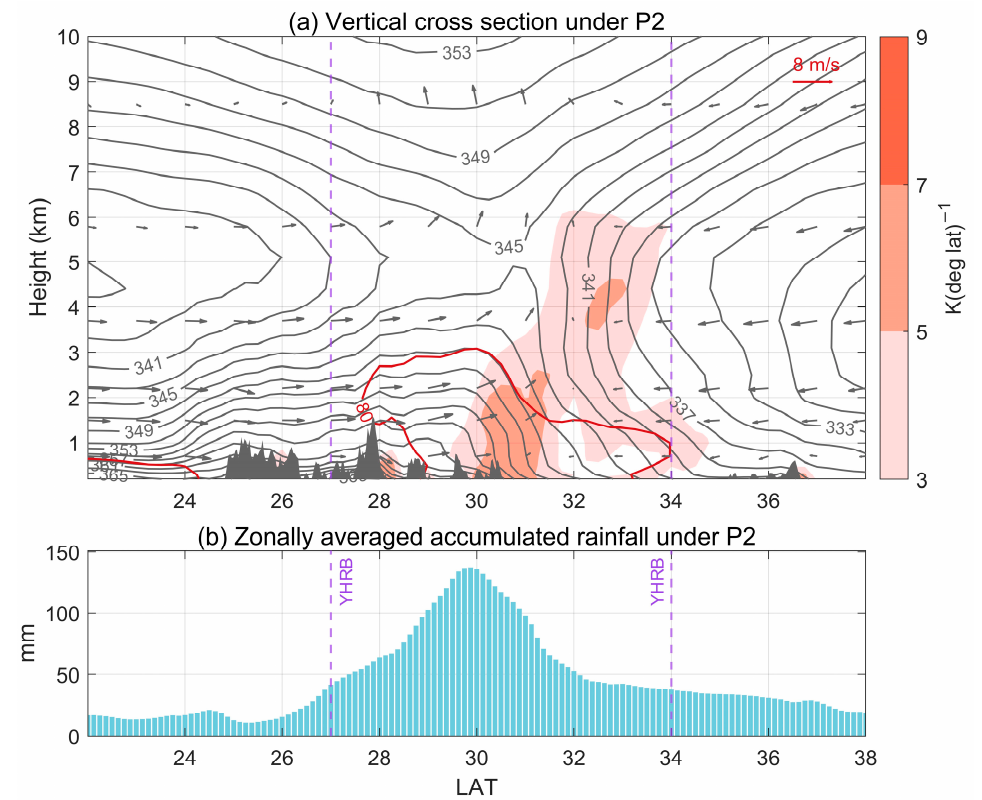
Figure 6. This is similar to Figure 5 but along 117.75 ◦ E under synoptic pattern of P2. The In-plane winds under P1 (Figure 5a) were steady southerlies, promoting the movement of moisture northward, with a low-level relative humidity over 80% in the YHRB.